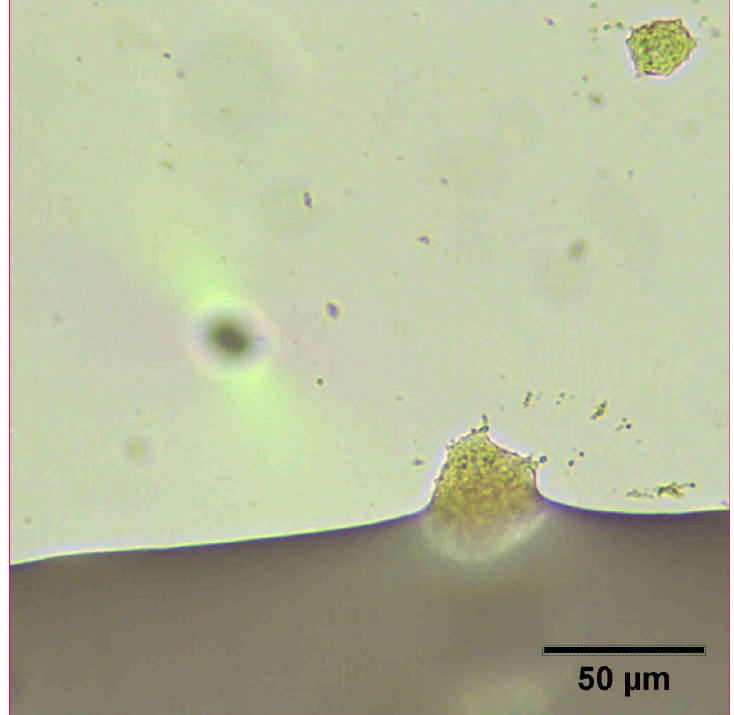
Figure 7. Optical microscope image of 10 mg/mL concentration naproxen nanosuspension after inkjet printing onto a film transparency. A drop of water was added to observe the redispersion of the dried nanosuspension droplets.